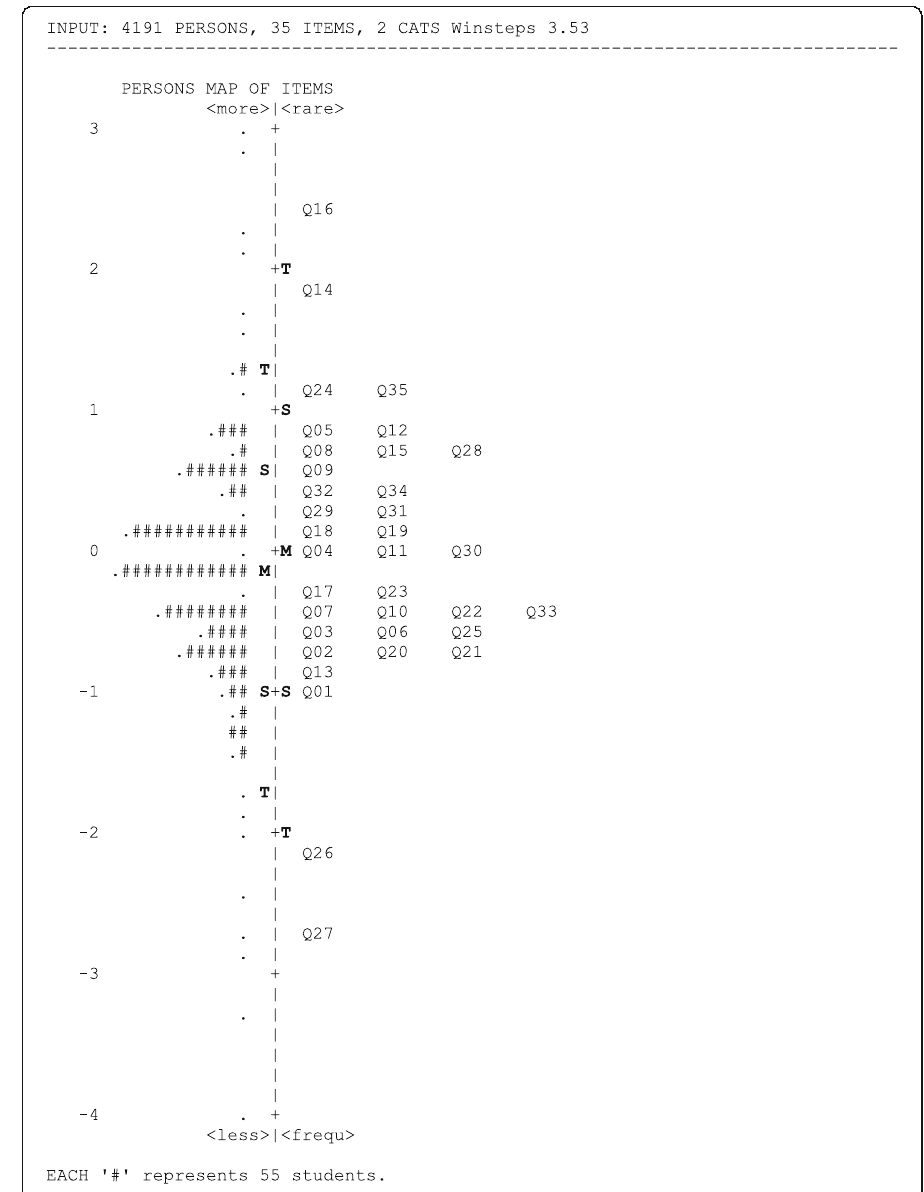
Fig. 1 The Wright distribution map for 1397 Grade 7 NA students and 35 science inference test